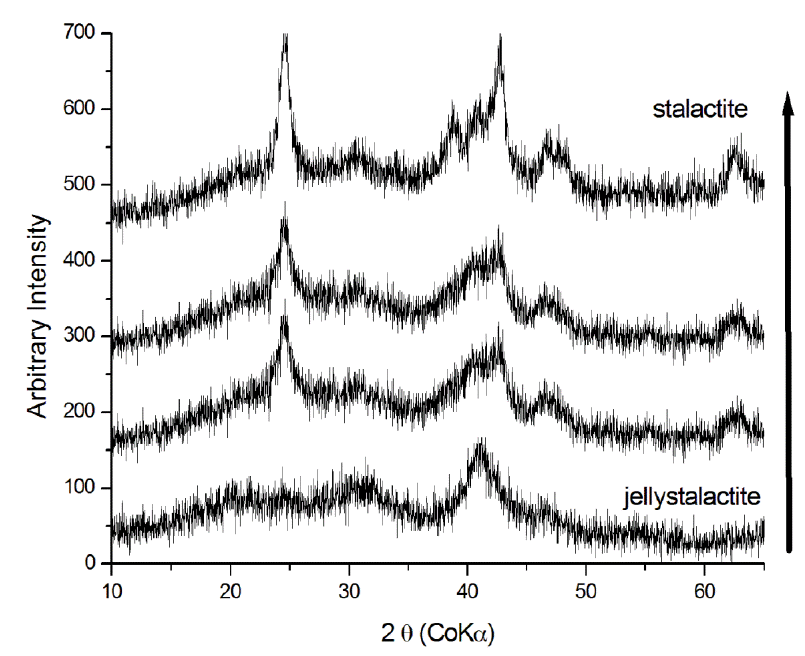
Figure 5. X-ray diffraction patterns for samples taken at different stages of evolution of representative samples of jelly stalactites (schwertmannite) and poorly crystalline goethite. The black arrow indicates schwertmannite into goethite transition.